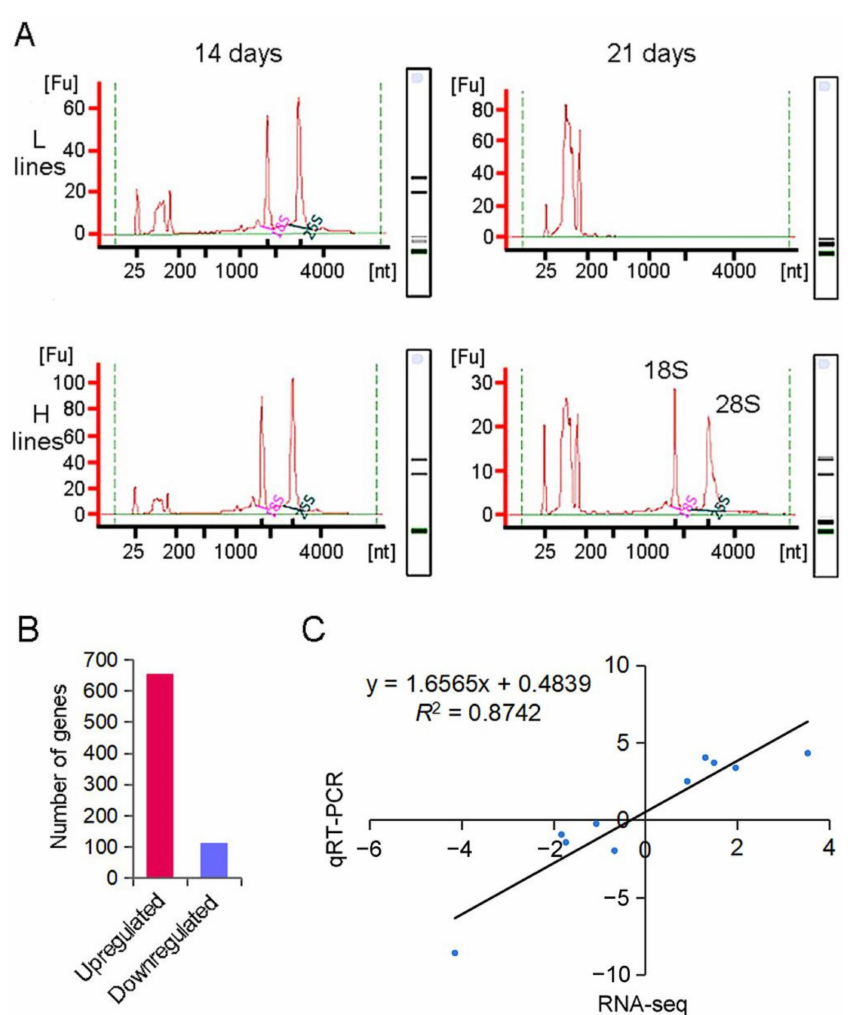
Figure 2. Comparison of RNA quality and DEGs between L and H accessions. ( A ) Comparison of RNA quality of developing seeds between L and H accessions at 14 and 21 days after flowering. nt: nucleotide. Fu: fluorescence value. ( B ) The number of genes up-regulated and down-regulated in L accessions. ( C ) Regression of qRT-PCR on RNA-sequencing DEGs. The correlation coefficient ( R 2 ) is indicated in the figure. DEGs: differentially expressed genes.